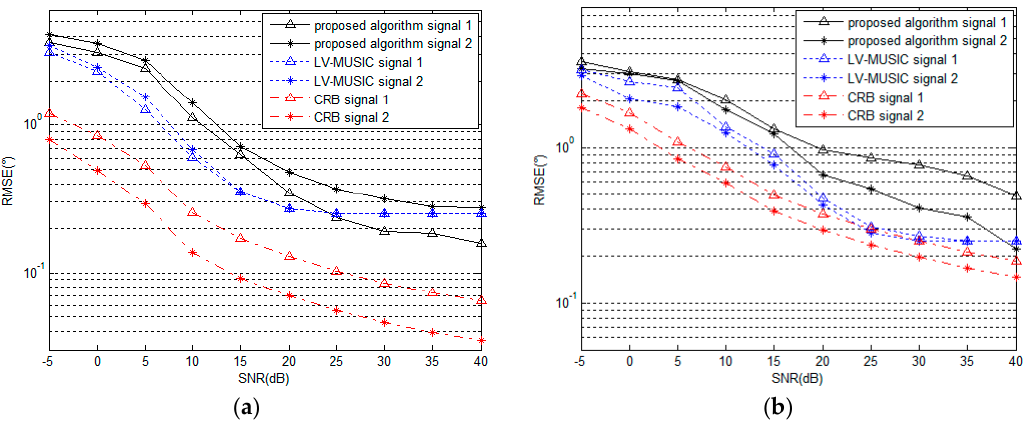
Figure 9. RMSE of ( a ) polarization auxiliary angle and ( b ) polarization phase difference estimation versus SNR (for 200 snapshots).